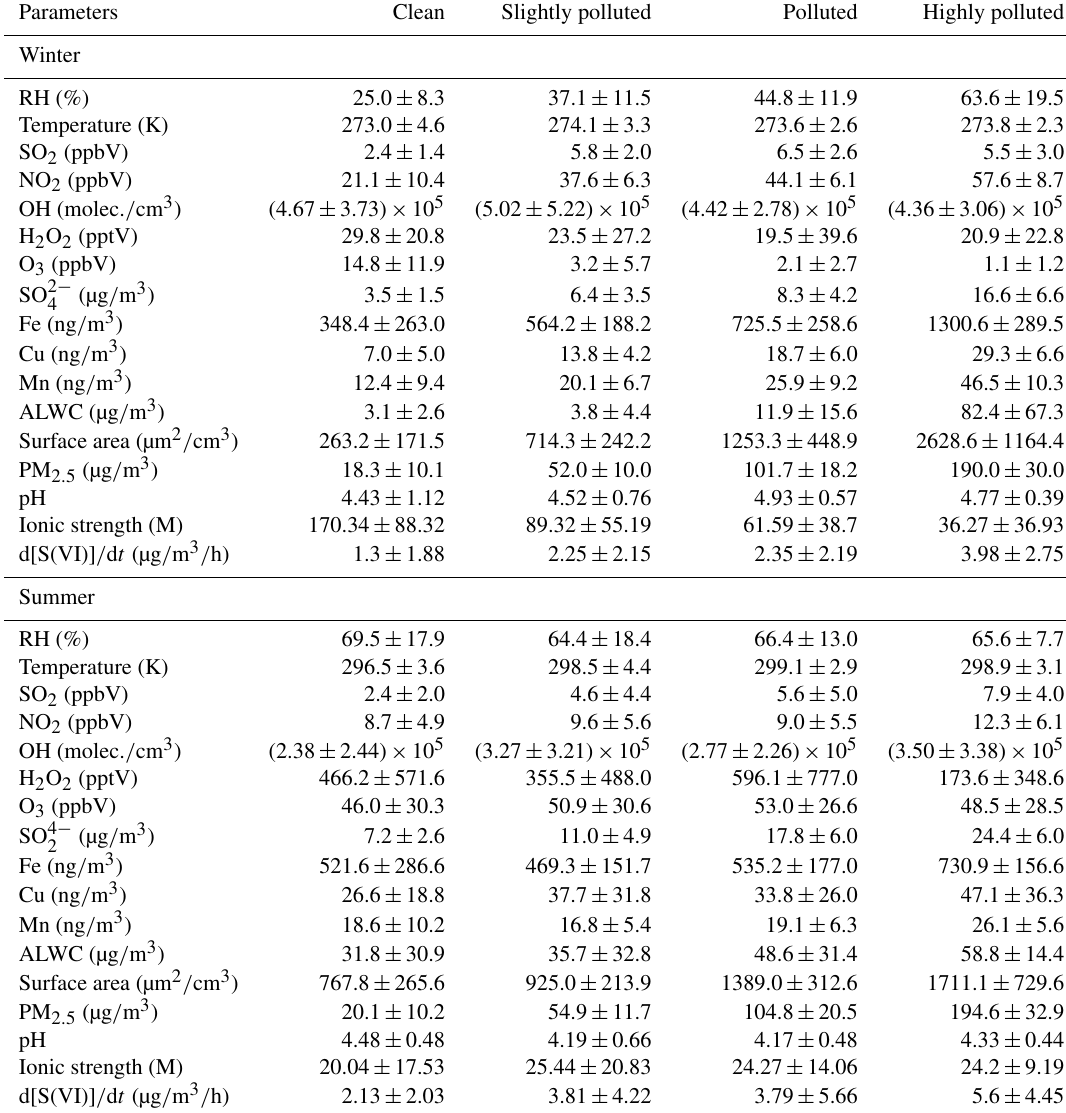
Table 1. Averaged results of observed meteorological parameters: trace gas concentrations; transition metal concentrations such as those of Fe, Cu and Mn; calculated ALWC; ionic strength; pH; and sulfate formation rates in different pollution conditions in two field campaigns ( ± 1 σ